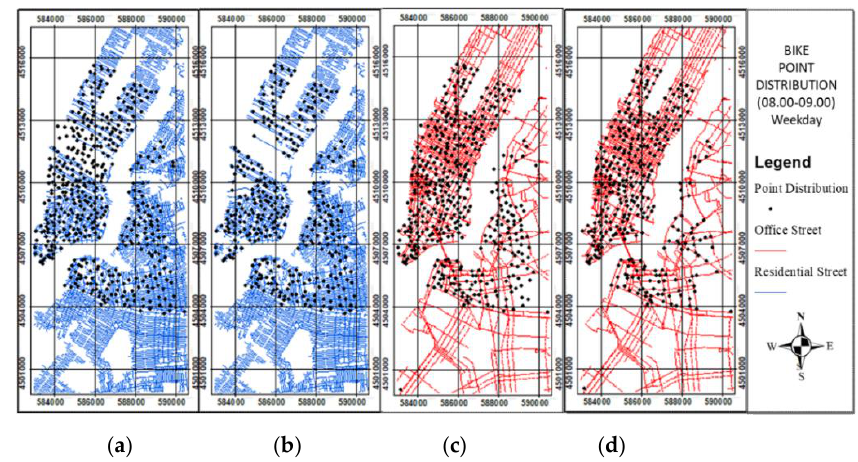
Figure 9. Bike point distribution during the first weekday peak time (08:00–09:00): ( a ) origin before data cleaning; ( b ) origin after data cleaning. ( c ) destination before data cleaning; ( d ) destination after data